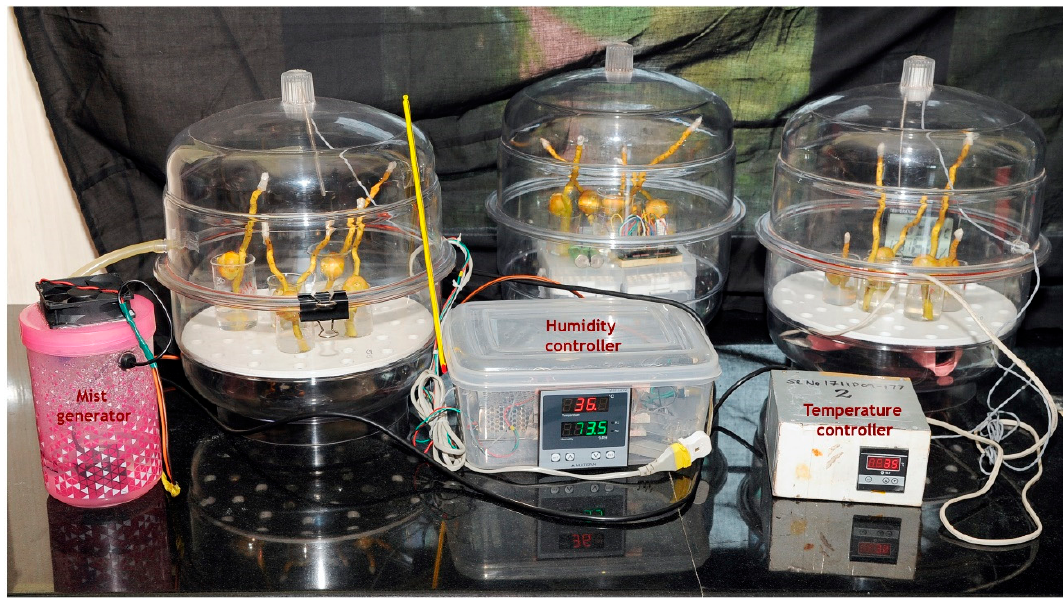
Figure 11. In vitro experimental setup to study the progamic phase of pollinated female flowers of the coconut variety WCT under high temperature and humidity treatments. From left: growth chambers having high temperature and humidity control, control chamber (room temperature and humidity) and high temperature chamber.